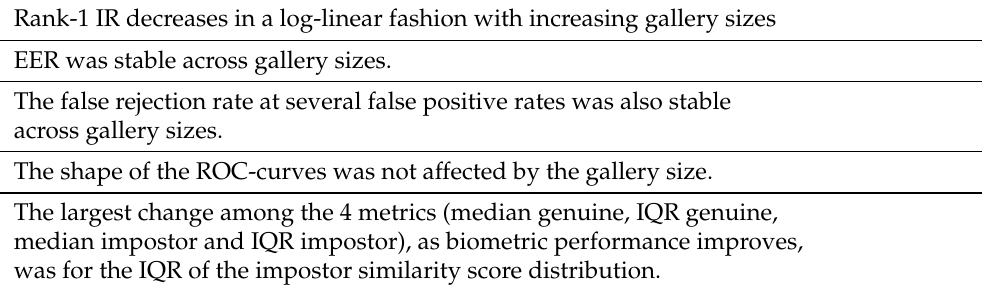
Table 1. Summary of Major